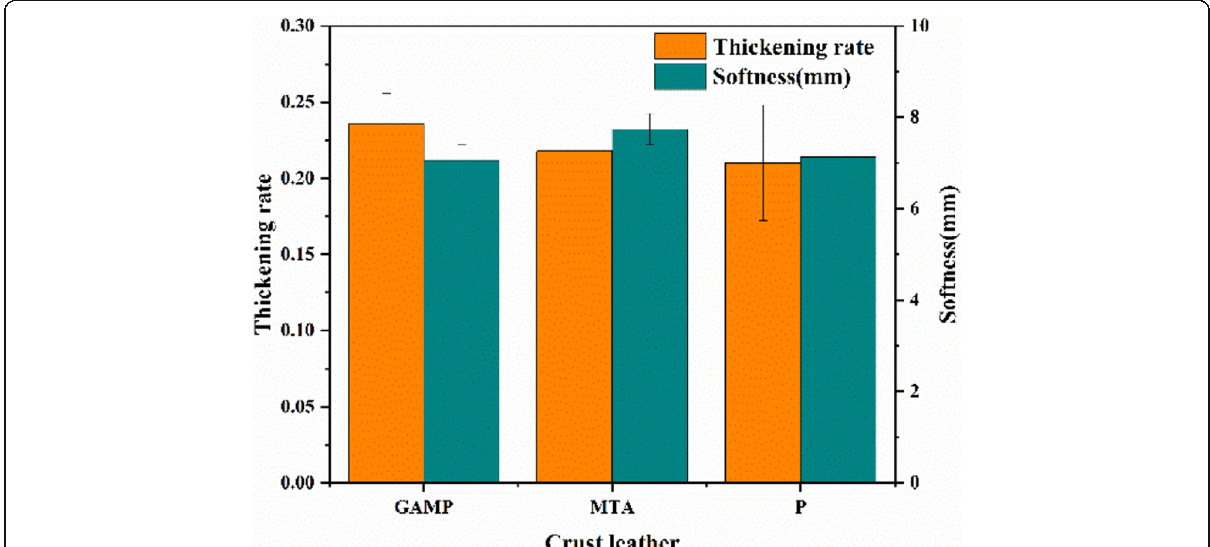
Fig. 9 The organoleptic properties of leathers treated with different retanning